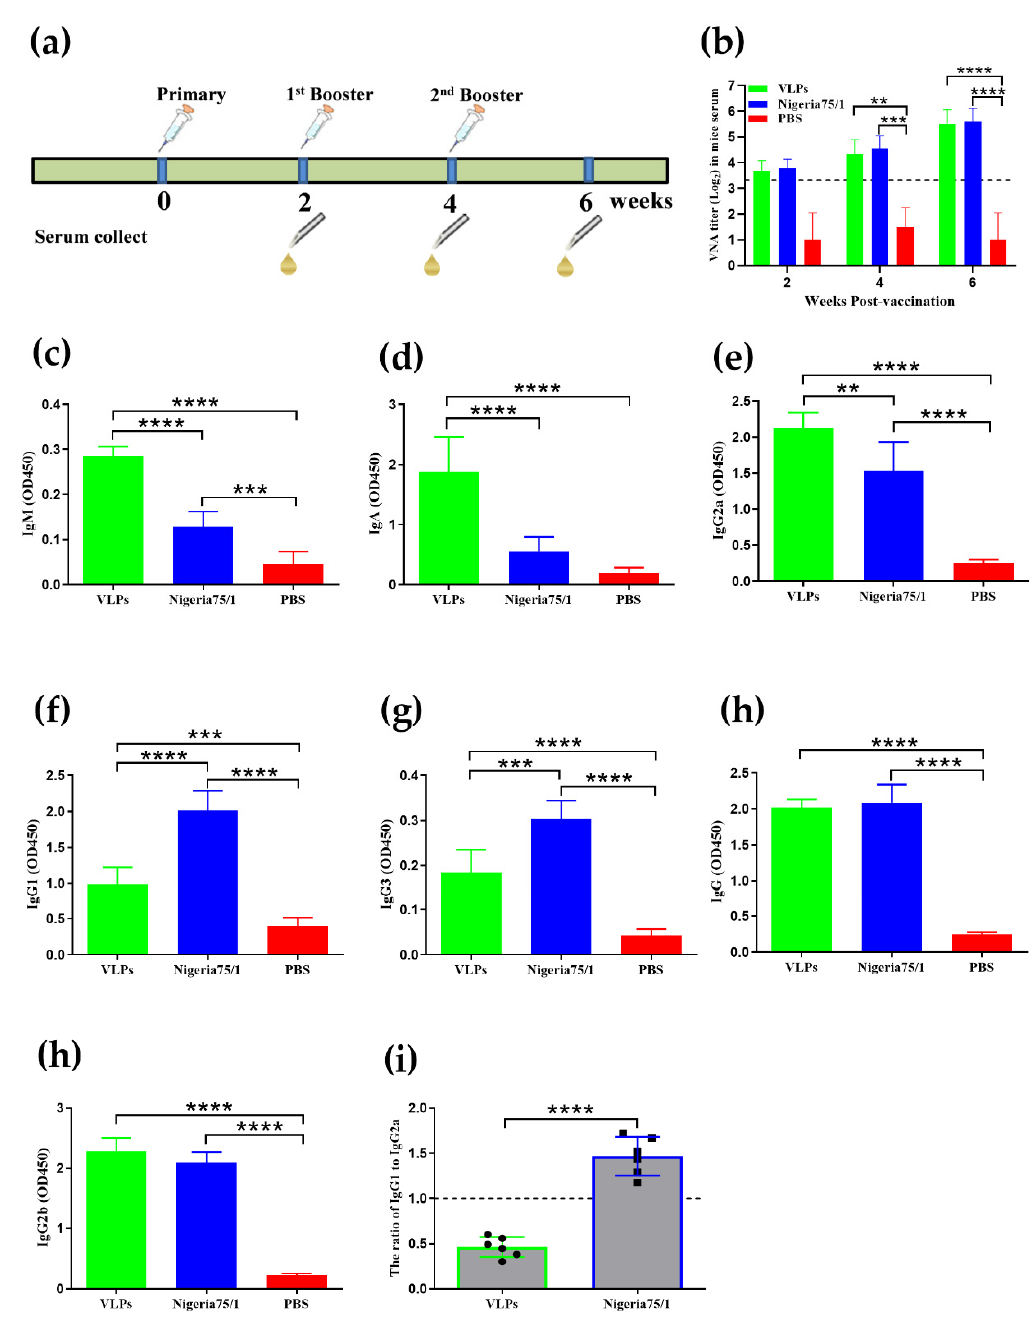
Figure 2. Immunization induces a humoral immune response and Th1 class immunity in mice. ( a ) Mice were vaccinated three times via the subcutaneous route at 2-week intervals with VLPs, PPRV Nigeria 75 / 1 or PBS. Blood sampling and serum isolation were performed 2, 4, and 6 weeks after the first immunization. ( b ) Virus-neutralizing antibody (VNA) titers were measured by fluorescent antibody viral neutralization (FAVN). ( c–i ) Serum was diluted by a factor of 5000, and total serum IgG and antibody subtypes were quantified by ELISA. The IgM (c) response were evaluated 1 week after the first vaccination, whereas IgA (d), IgG2a (e), IgG1 (f), IgG3 (g), IgG (h), and IgG2b (i) responses were determined 2 weeks after the second immunization. ( j ) The IgG1 / IgG2a ratio was measured. Dotted lines represent antibody titers greater than ten, indicating positive serum conversion. Significant di ff erences were analyzed by one-way or two-way ANOVA and indicated as follows: * P < 0.05, ** P < 0.01, *** P < 0.001, **** P < 0.0001.